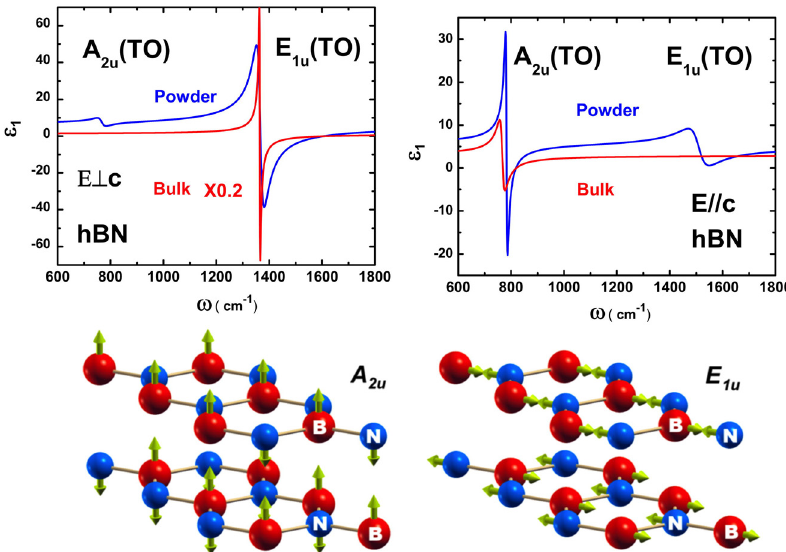
Figure 6: (a) Real part of the dielectric constant for the low frequency intfrared active mode at 783 cm − 1 (blue)and (b) for the highfrequencymodeat1367cm − 1 (red).Note the negative values in the Reststrahlen band. (c) Atomic motions of the out-of-plane (A 2u ) and in-plane (E 1u ) IR-active modes of h- BN. This fi gure is plotted from numerical data taken in references [22,